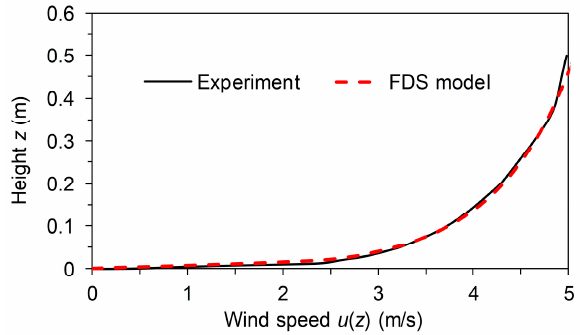
Figure 8. Comparison between the wind profiles of the experiment [36] and the FDS model.